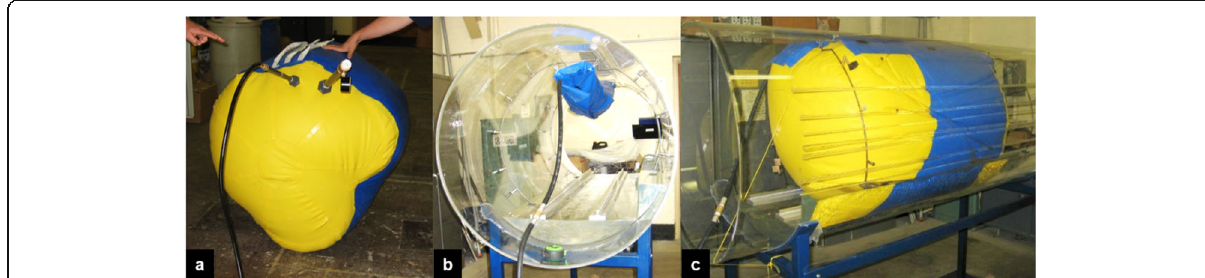
Fig. 2 Phase 1, reduced-scale testing: a Unconfined inflation of 1:5.7 prototype; b Folded plug ready for deployment in acrylic tunnel mockup; c Inflation in the acrylic tunnel